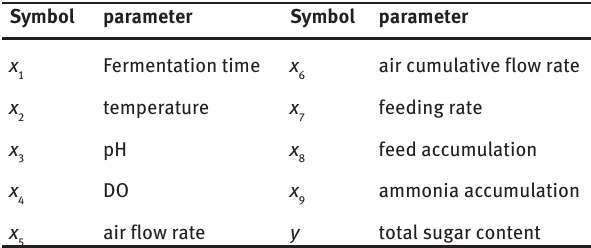
Table 1: Input and output variables for soft sensor modeling of CTC.